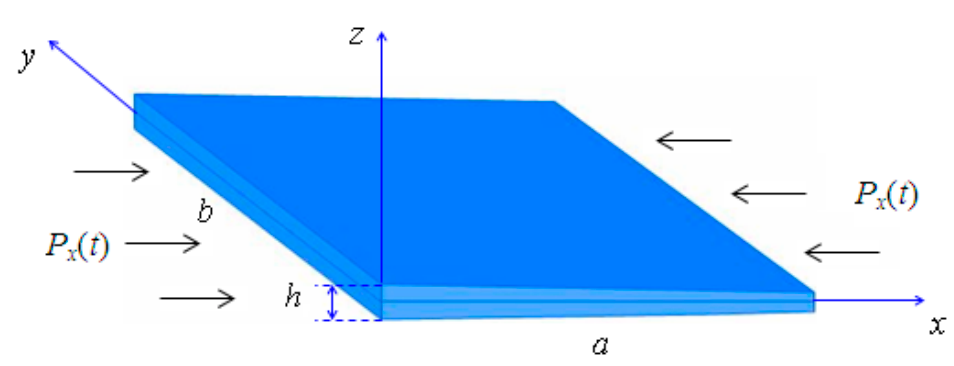
Figure 1. An orthotropic viscoelastic rectangular plate of variable thickness under the action of periodic in-plane loads.